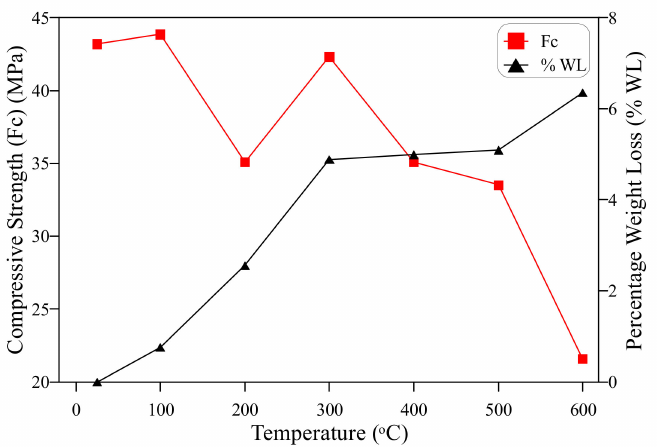
Figure 7. The relation of compressive strength and percentage weight loss of the cube specimens at different temperatures.